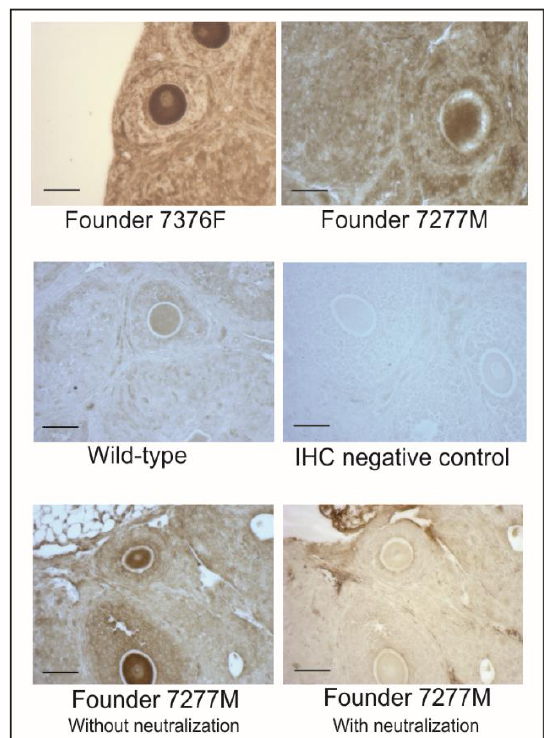
Figure 6. Immunohistochemical detection of hDENND1A.V2. Immunohistochemical studies were performed in ovaries from wild-type and CMV-hDENND1A.V2 transgenic mice using an anti- hDENND1A.V2 rabbit antibody. The figure shows representative images from the founder 7376F, founder 7277M, wild-type, and negative control incubated without a primary antibody. Samples were processed in parallel and all the sections were incubated in the peroxidase reaction for exactly four minutes in order to increase the detection of the signal. As expected, due to the global expression of the CMV promoter, immunoperoxidase staining is seen in all compartments in the transgenic ovaries, with a much greater intensity than in the wild-type ovary or the negative control. Validation of the specificity of the hDENND1A.V2 primary antibody was performed by neutralization of the antibody with 10 μg/mL of an hDENND1A V2-specific peptide. Bar = 50 